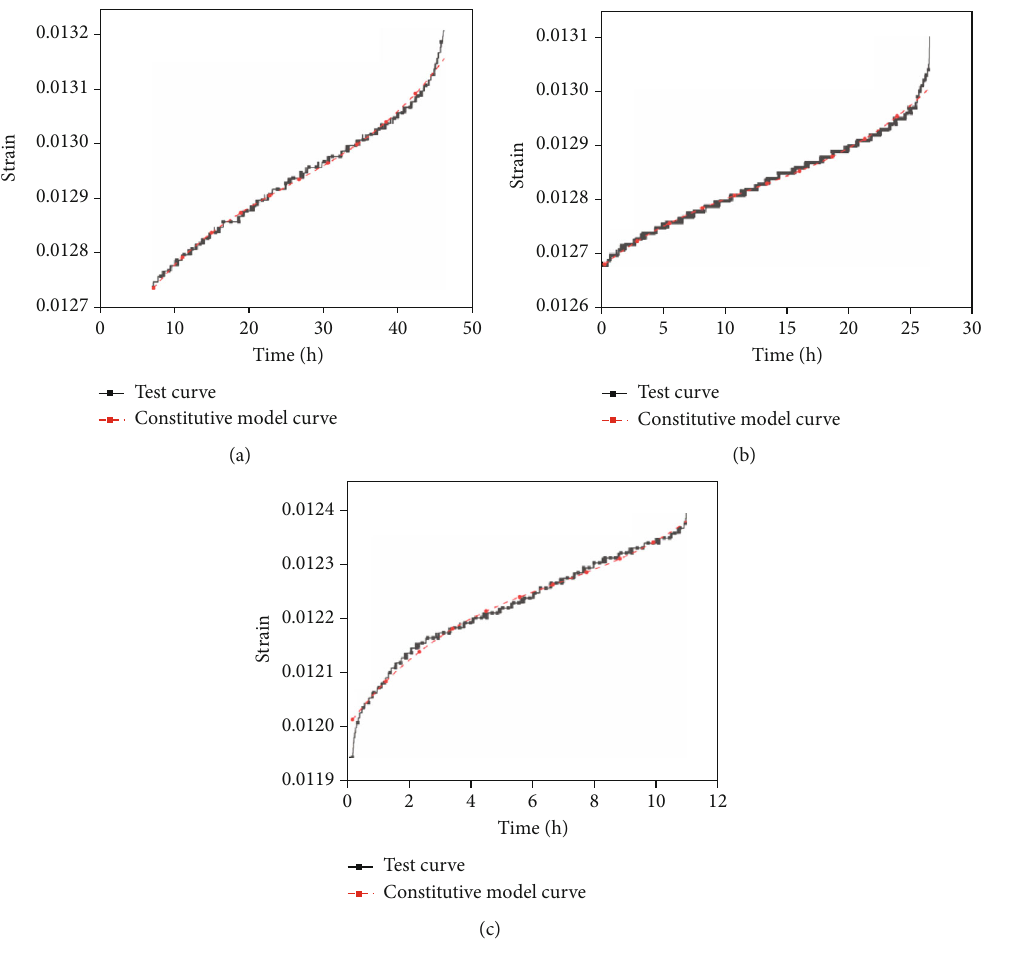
Figure 17: Creep test and constitutive model curves of samples under di ff erent pH conditions. (a) Sample soaked with distilled water. (b) Sample under the pH = 6 acidic solution. (c) Sample under the pH = 5 acidic